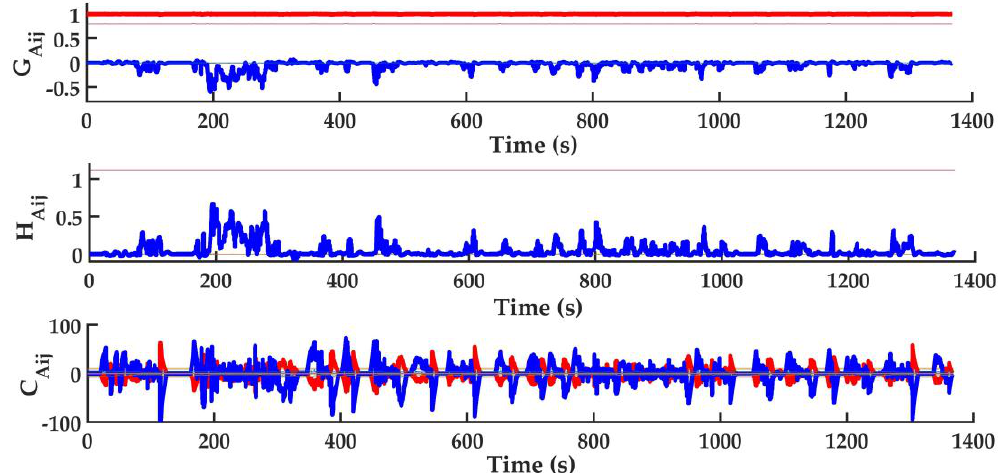
Figure 7. G A , H A and C A variation of AMPC.